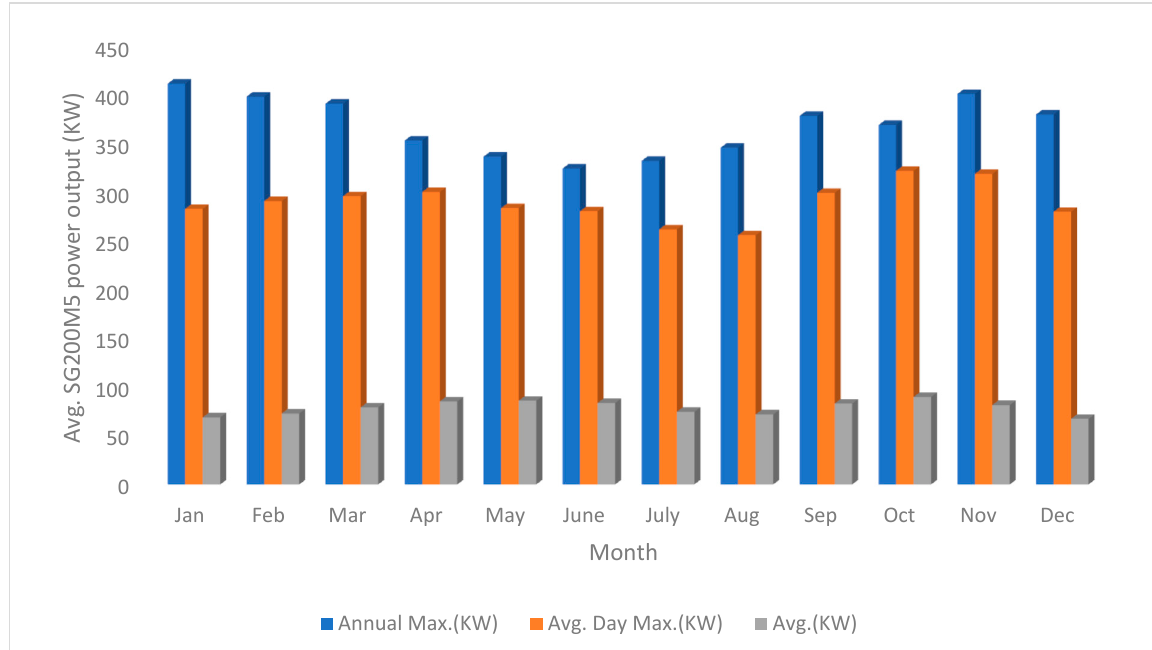
Figure 6. Peimar SG200M5 average output power in KW.